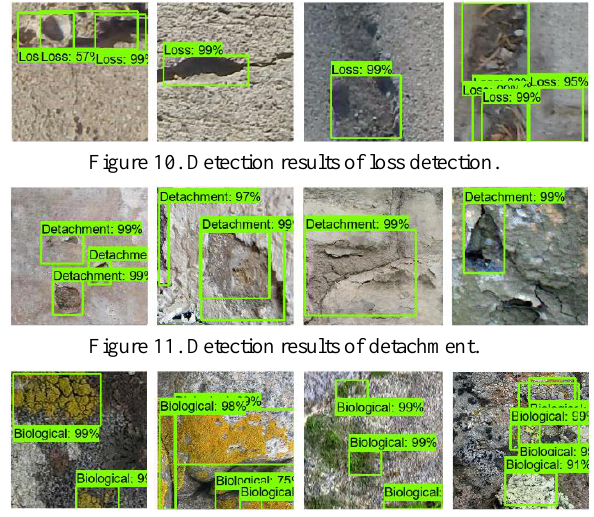
Figure 12. Detection results of biological